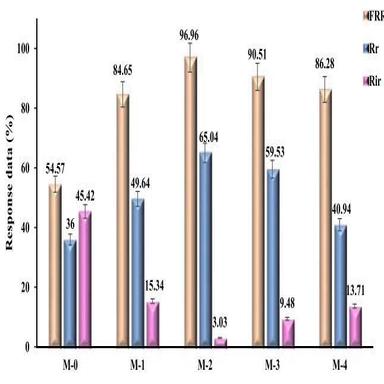
Fouling parameters for fabricated photocatalytic membranes.